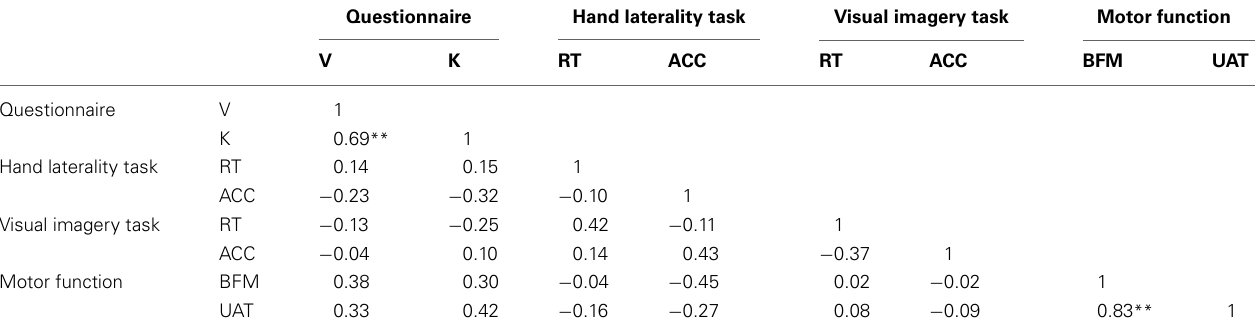
Table 3 | Spearman correlations between the questionnaire, the hand laterality task and the visual imagery task of patients ( N =